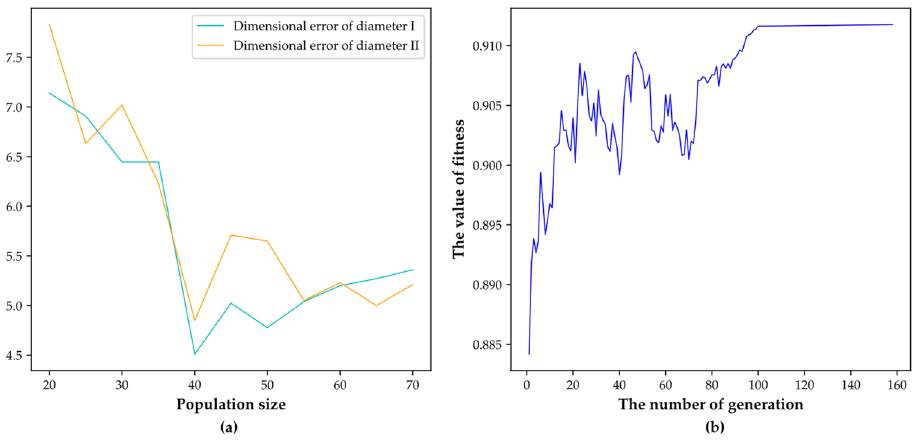
Figure 10. The effects of parameters of GA. (a) The effects of population size, (b) The effects of generation number.